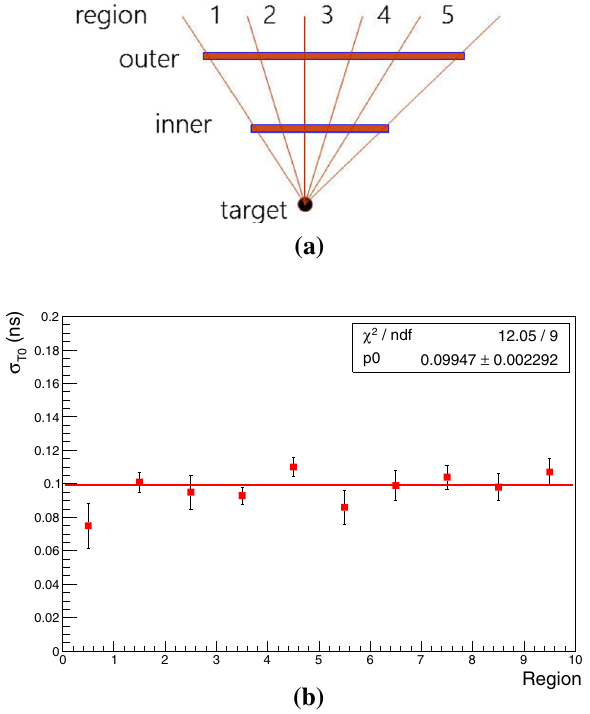
Fig. 24 (Top) Different hit position regions along the beam direction. (Bottom) T0 time resolution in each region